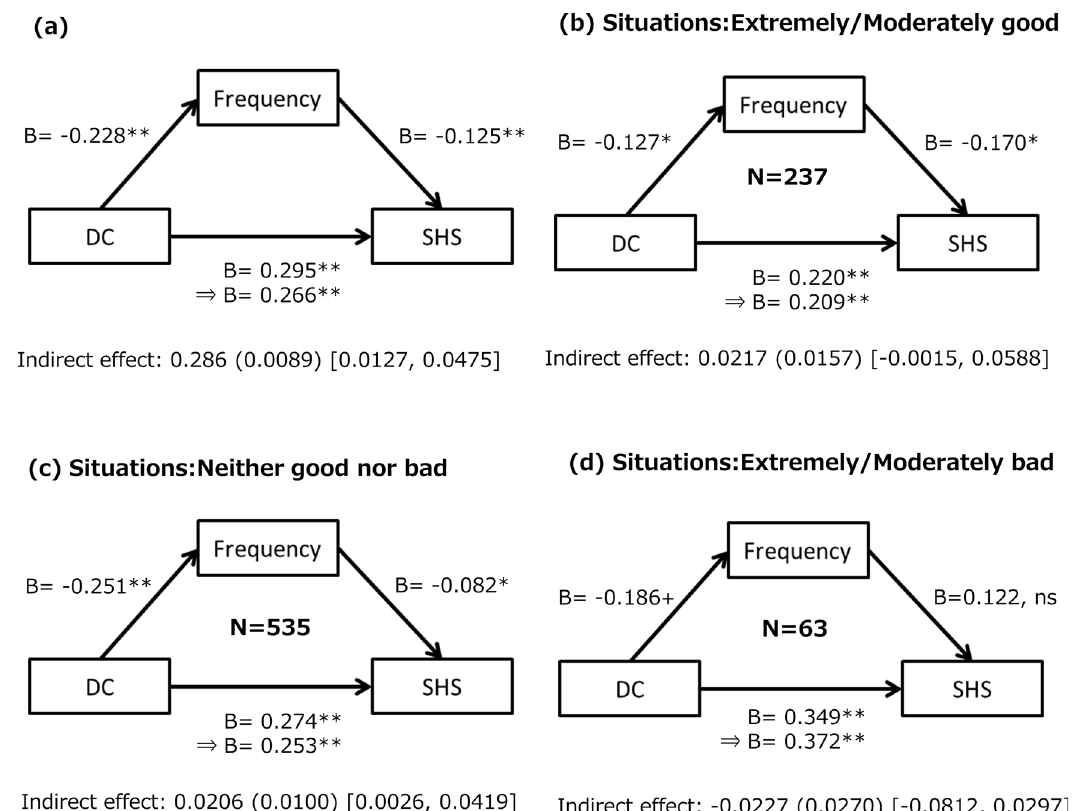
Fig. 4 Mediation analysis between travel frequency and subjective wellbeing. All B ’ s represent unstandardized regression coef fi cients obtained through bootstrapping using 10,000 resamples. The range in brackets represents the 95% CI of the indirect effect. ** p < 0.01, * p < 0.05, + p <